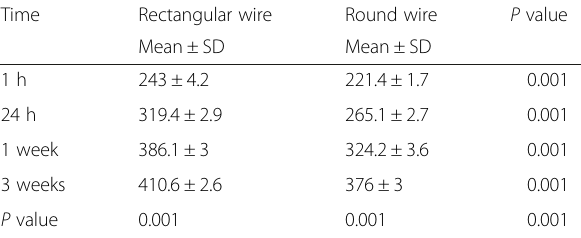
Table 2 Release of nickel in rectangular and round NiTi wires at different time points